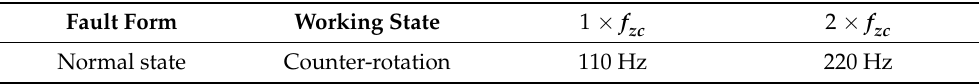
Table 2. The FCF of normal state